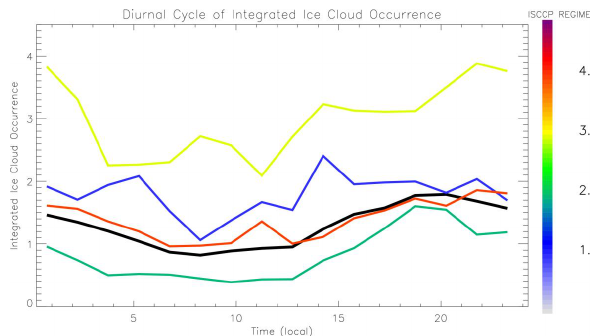
Figure 11: Same as Fig. 3 but for the ISCCP regimes: CD (blue), STC (green), CC (yellow), and MIX (red).